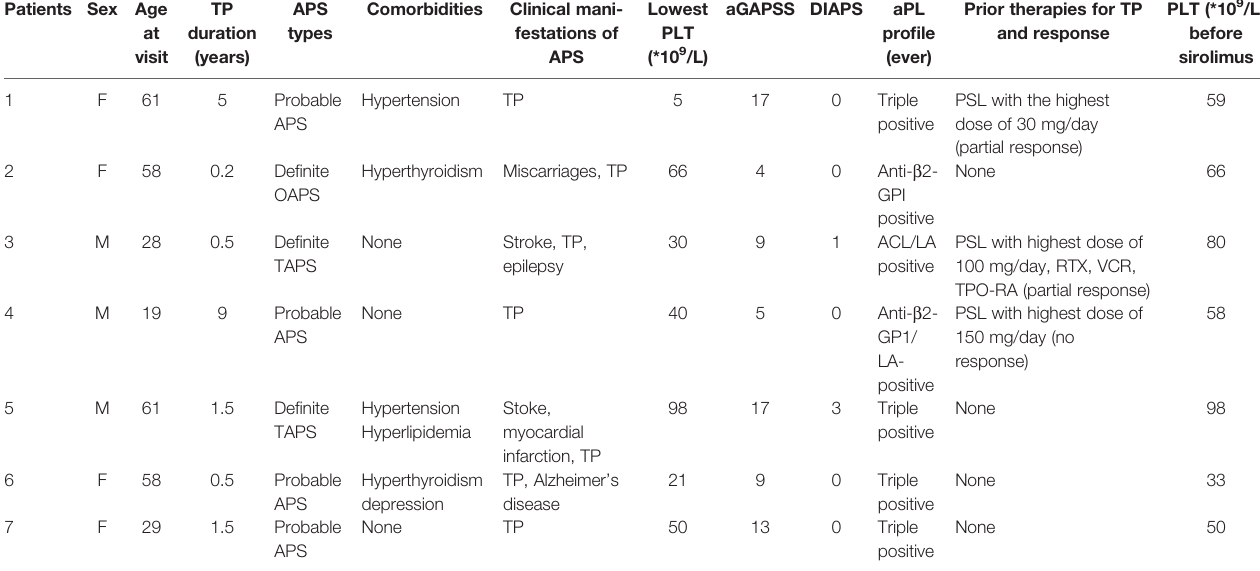
TABLE 1 | Baseline characteristics of patients with primary APS-TP at enrolment. Patients Sex Age